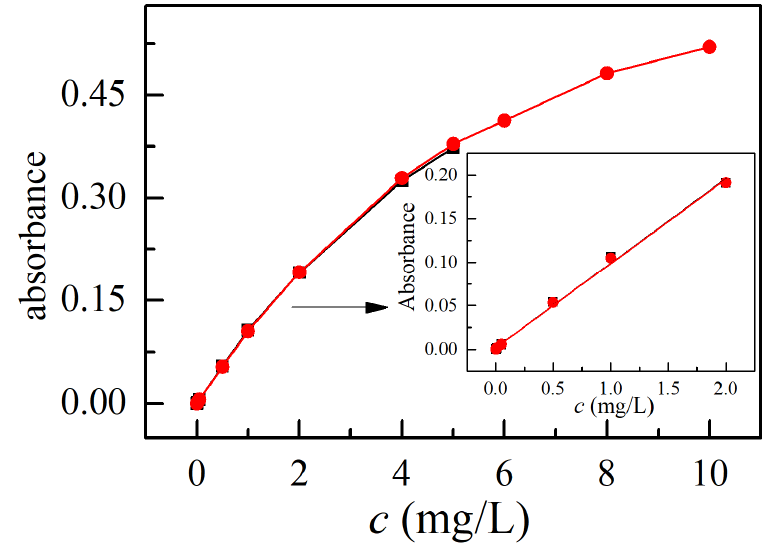
Figure 8. Calibration curves for the analysis of Cd(II) in the absence ( black square ) and the presence of dissolved DMSA/PDA/ZnO ( red circles ); inset shows the linear concentration region.